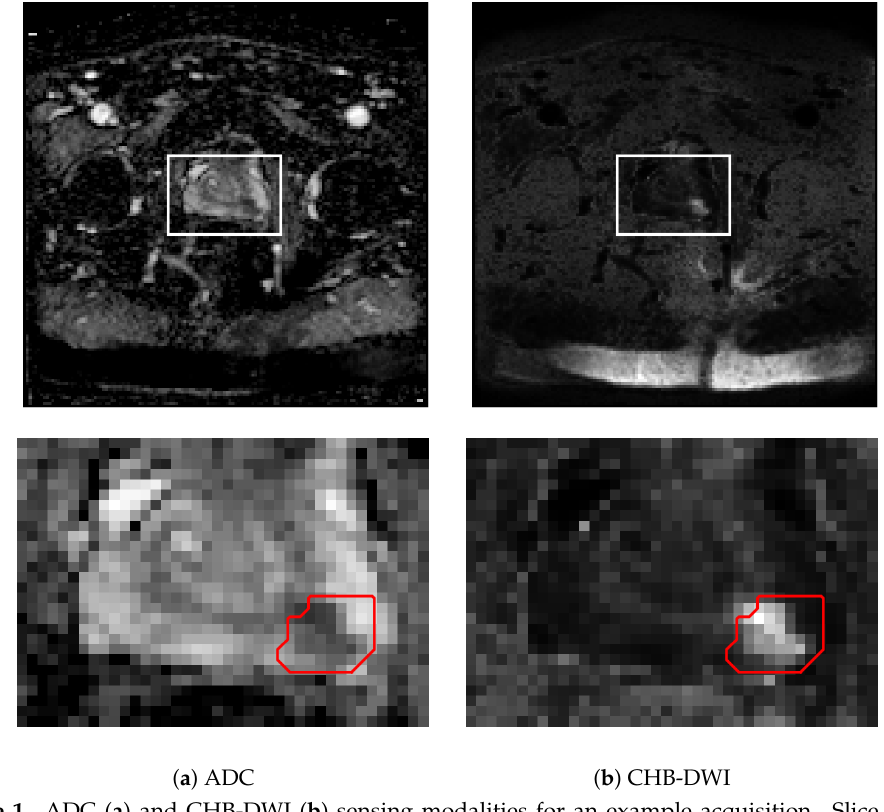
Figure 1. ADC ( a ) and CHB-DWI ( b ) sensing modalities for an example acquisition. Slice (top). Cropped view of the prostate (bottom). This patient has pathologically-verified prostate in zone 10 (Gleason score of 8), contoured in